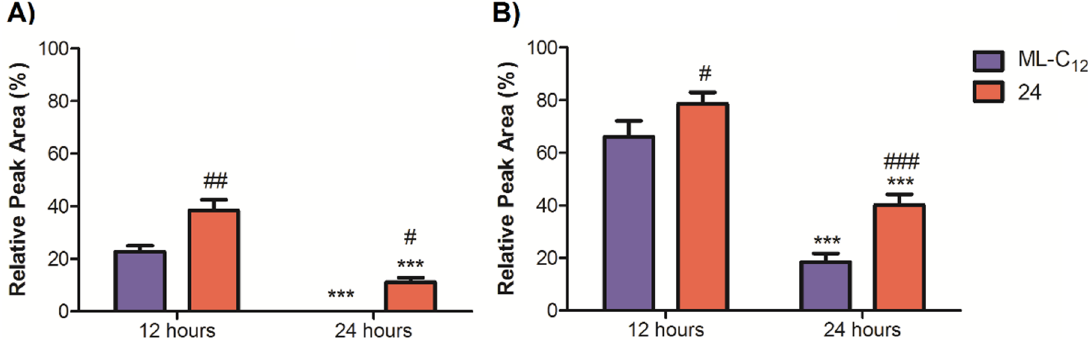
Figure 8 . Plasma stability of glycoliposomal entrapped Dynantin. Dynantin was combined with 24 or ML-C 12 at 1:5 ( A ) and 1:10 ( B ) ratios of peptide: glycolipid. Particles were incubated in human plasma at 37 °C and the levels of Dynantin remaining at various time points were analyzed by RP-HPLC in the presence of 0.1% trifluoroacetic acid and detected by absorbance at 210 nm. Peptide amounts were calculated relative to the quantities determined at time point zero, and data are shown as the average ± SEM of three separate experiments. *** p < 0.001 as compared to respective formulation at 12 h time point, ### p < 0.001, ## p < 0.01 and # p < 0.05 as compared to ML-C 12 formulation at respective time point.